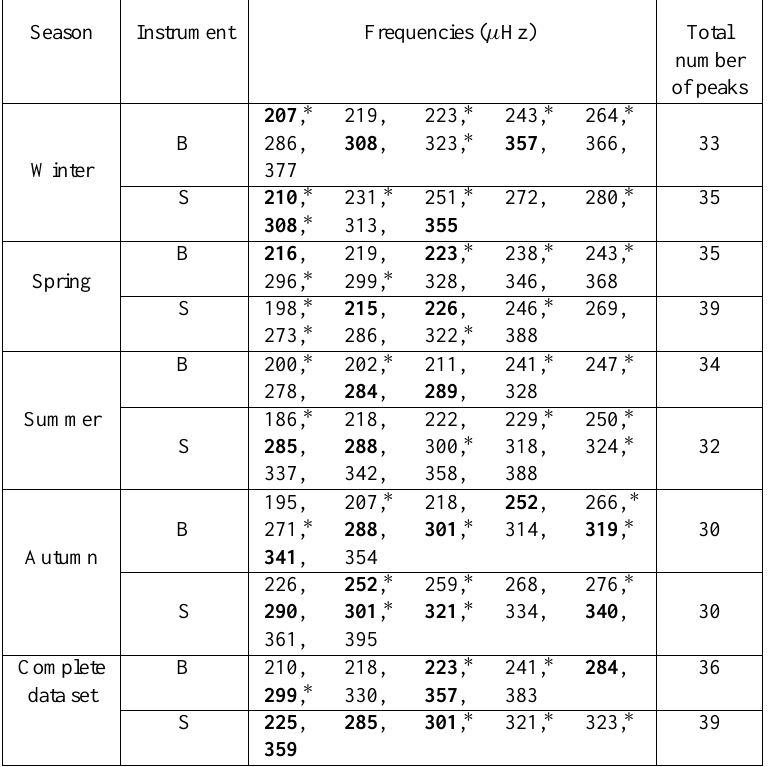
Season Instrument Frequencies ( µ